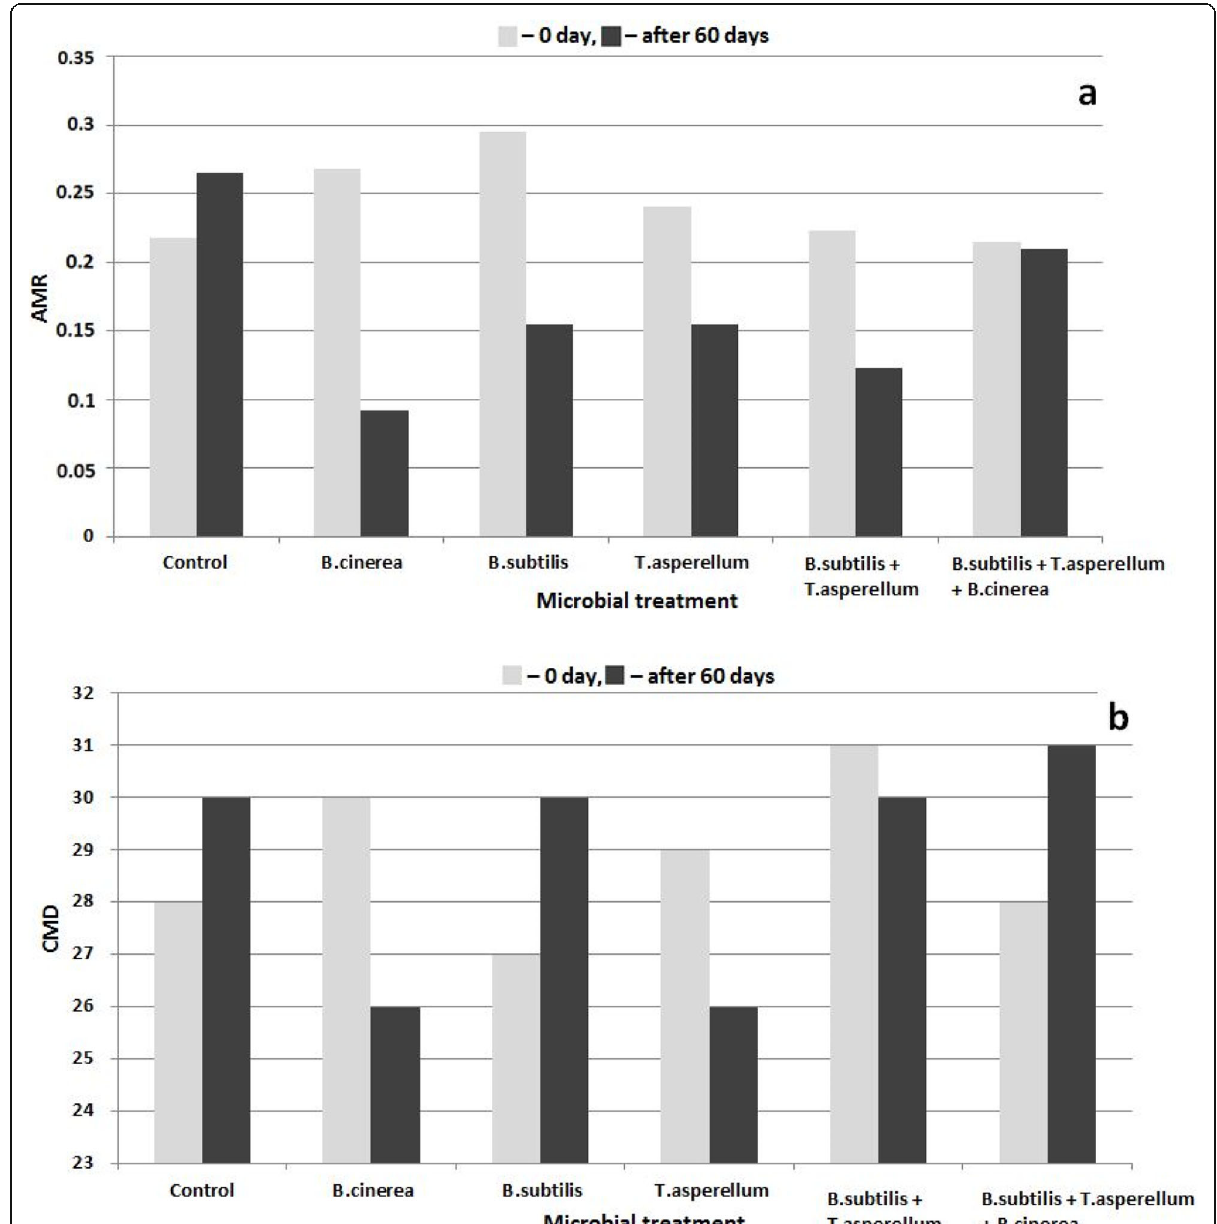
Fig. 3 a Average metabolic response (AMR) and b community metabolic diversity (CMD) in differently treated soil samples at different times. * — significant ( P < 0.05) difference from control at the same time; * — significant ( P < 0.05) difference from control at the same